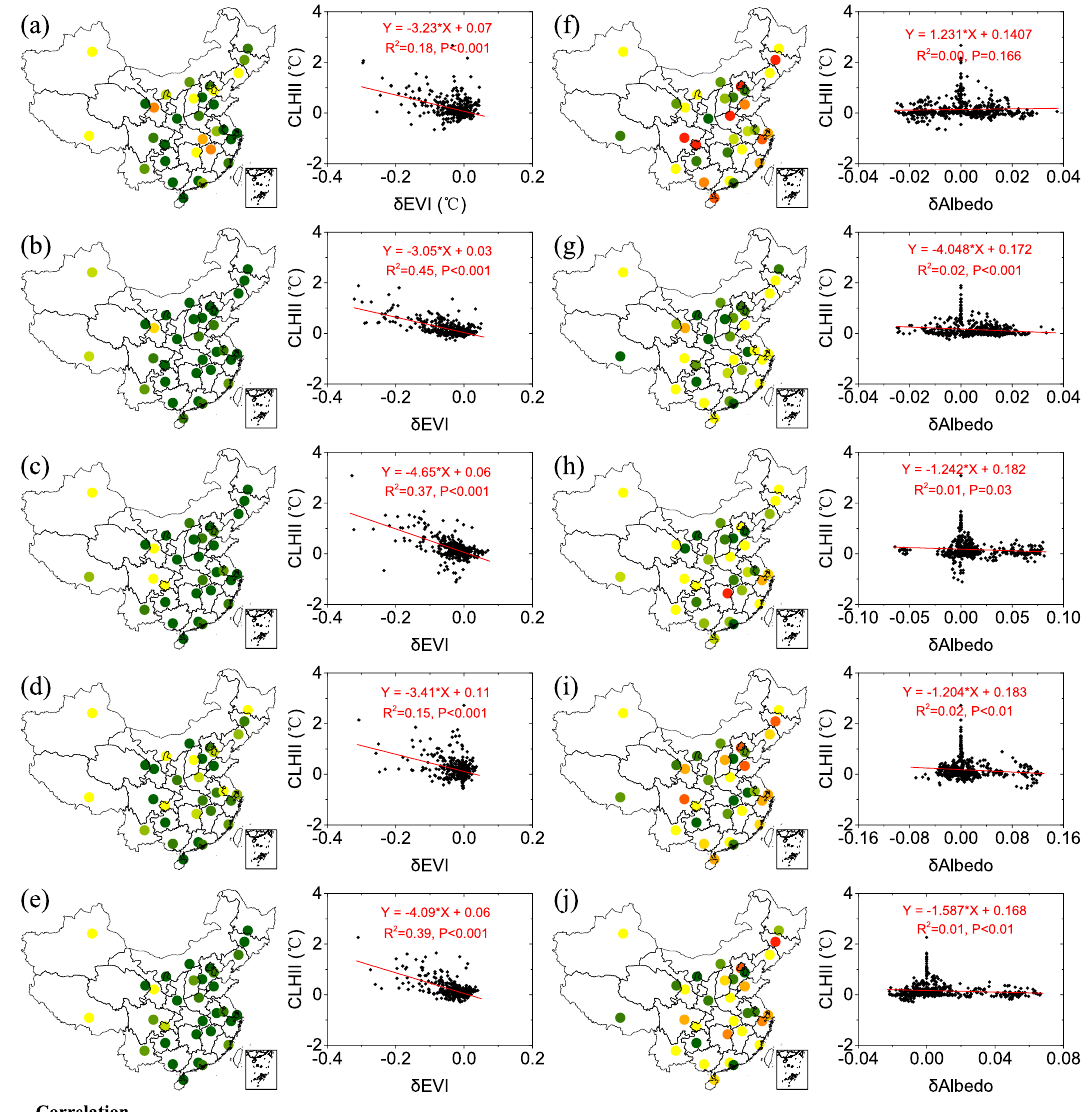
Figure 10. Relationships between CLHII and vegetation and surface albedo. Correlations and relationships between CLHII and δEVI are shown in the vector and scatter diagram in ( a ) spring, ( b ) summer, ( c ) autumn, and ( d ) winter, respectively. ( e ) Shows the correlation of annual CLHII with δEVI. Correlations and relationships between CLHII and δAlbedo are shown in the vector and scatter diagram in ( f ) spring, ( g ) summer, ( h ) autumn, and ( i ) winter, respectively. ( j ) Shows the correlation of annual CLHII with δAlbedo. The red line is the linear regression line.